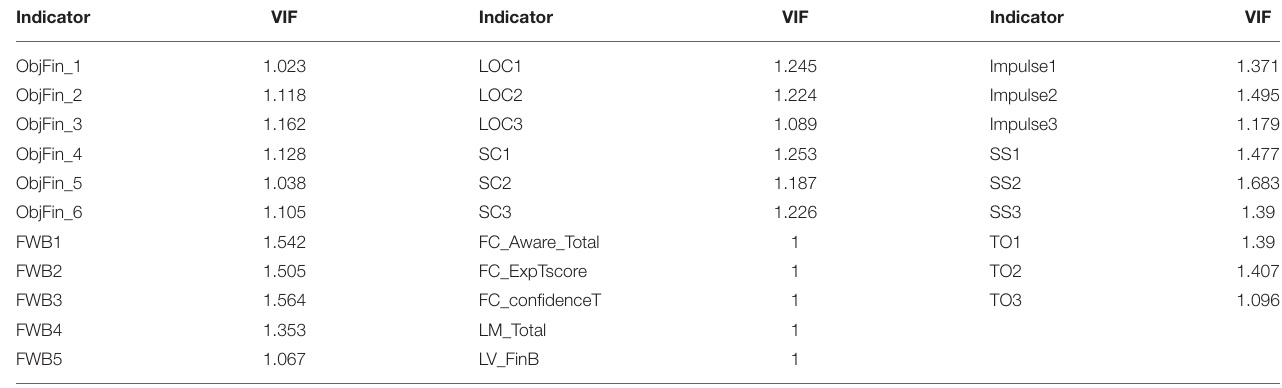
TABLE 7 | Collinearity assessment.